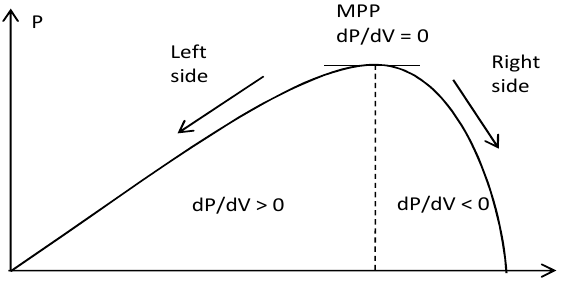
Figure 4. Operation principles of the IC method on the P-V curve.